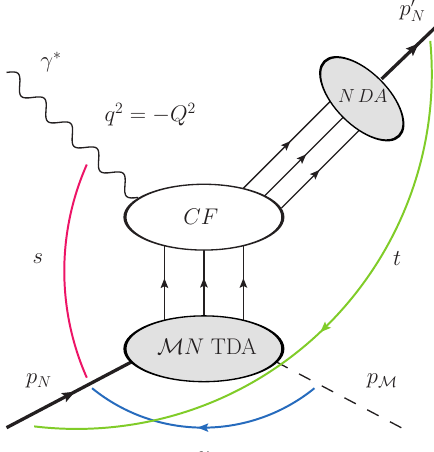
N in → M N TDA, depicts M p N ) 2 , u = ( p p N ) 2 N − M −